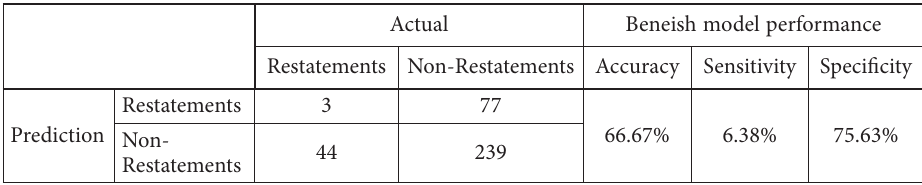
Table 4. Descriptive analysis for tested variables for Beneish model